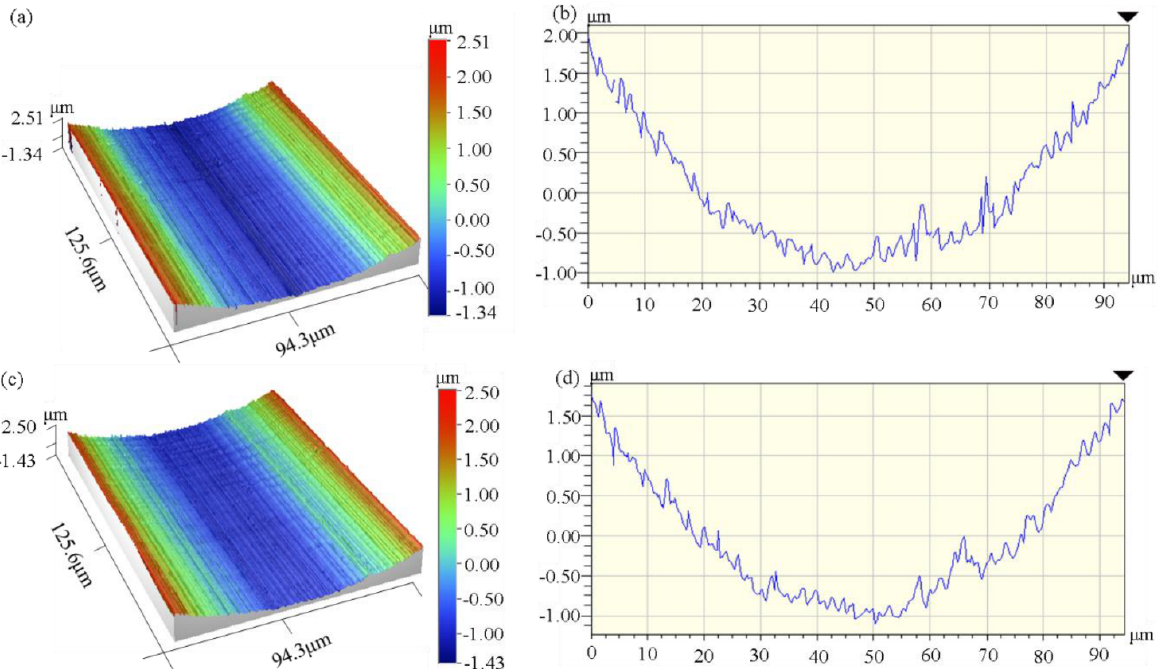
Figure 6. Morphology and profile of the micro-grooved surface for the speed corresponding to 60 mm/min; ( a , b ) the depth of cut was 5 µ m; ( c , d ) the depth of cut was 15 µ